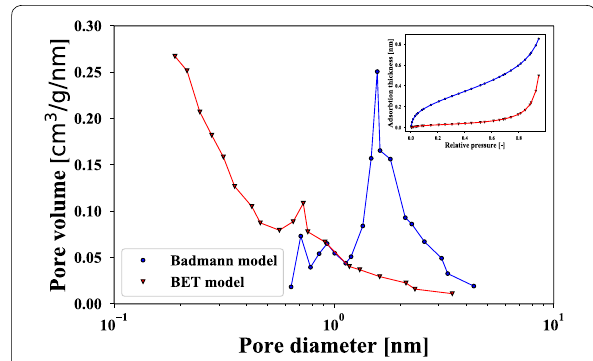
Fig. 6 Pore size distribution from water vapor sorption isotherm, calculated by BJH method, data from Maruyama et al.